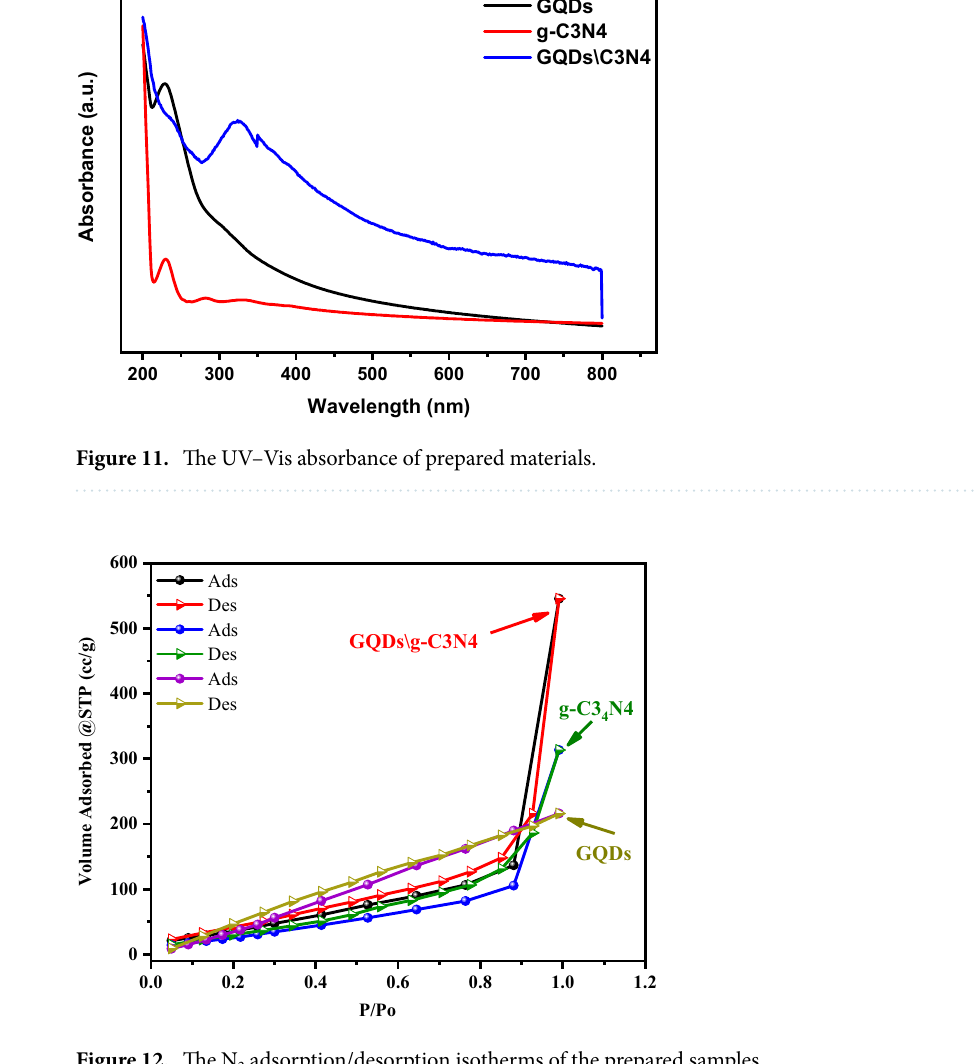
Figure 12. The N 2 adsorption/desorption isotherms of the prepared samples.